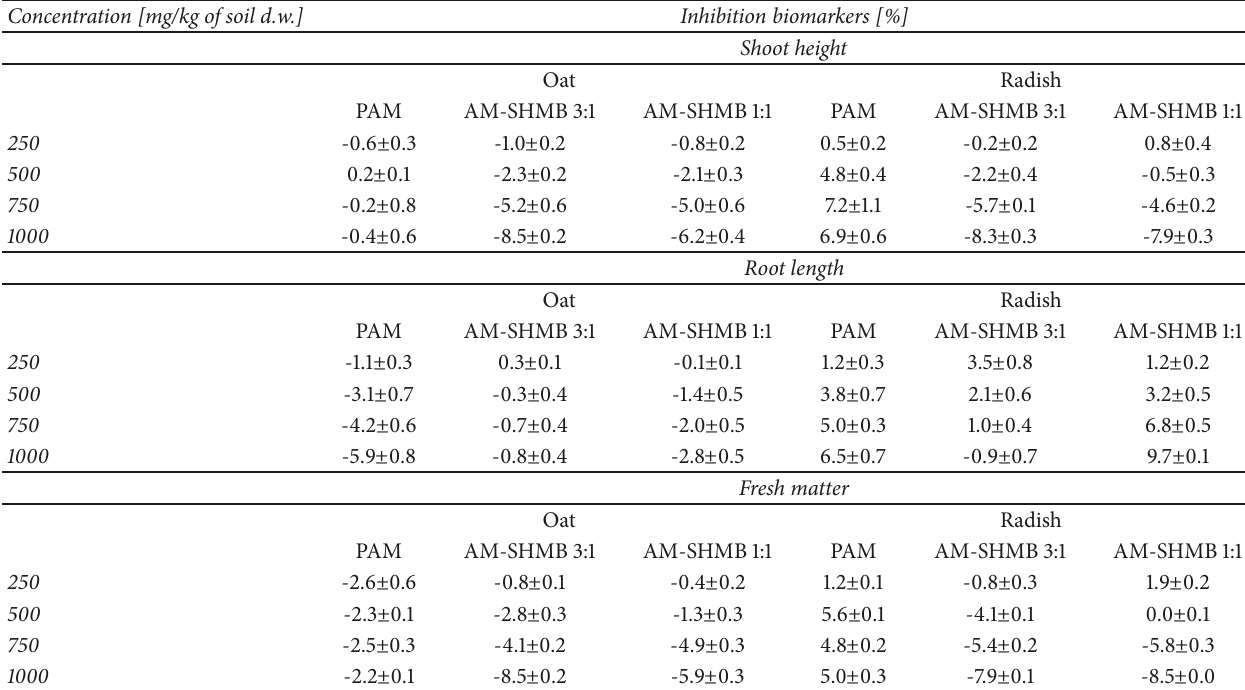
Table 2: Effect of PAM, AM-SHMB 3:1, and AM-SHMB 1:1 hydrogels on the shoot height, root length, and fresh matter of oat and radish seedlings (mean ±